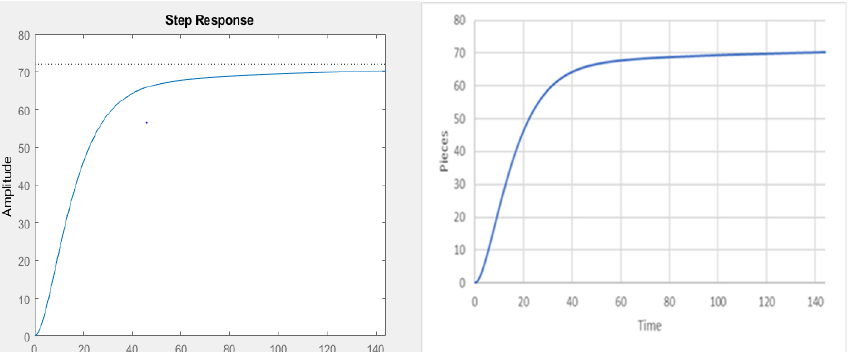
Figure 16. Ironing process output at step input and Stella output.